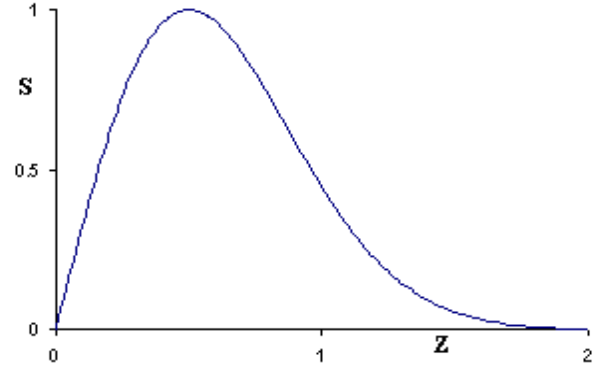
FIG. 8. (Color) Sketch of normalized shape function S (cid:3) s (cid:4) z (cid:6) =s vs normalized axial distance Z (cid:3) z=l 0 a 2 =r 2 and l is a measure of the axial extent of the primary strap. p p